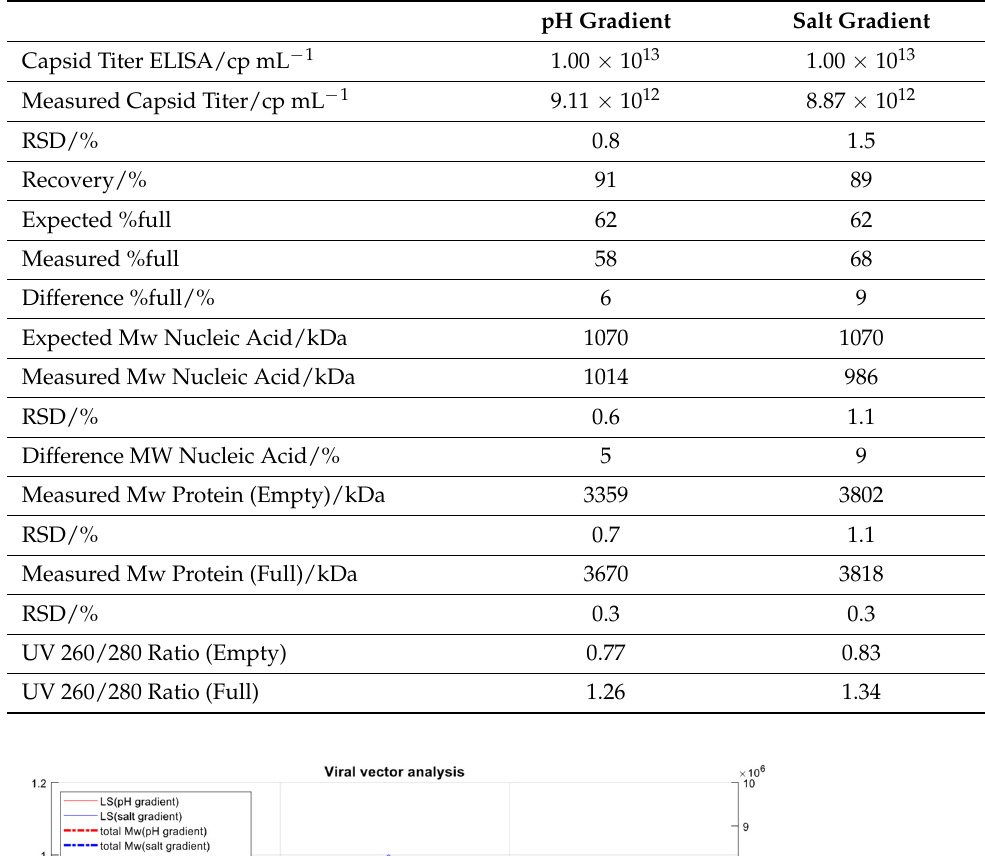
Table 3. Comparison of IEC-MALS method performance results of empty and filled AAV8 capsids obtained by a linear pH gradient and a linear salt gradient.